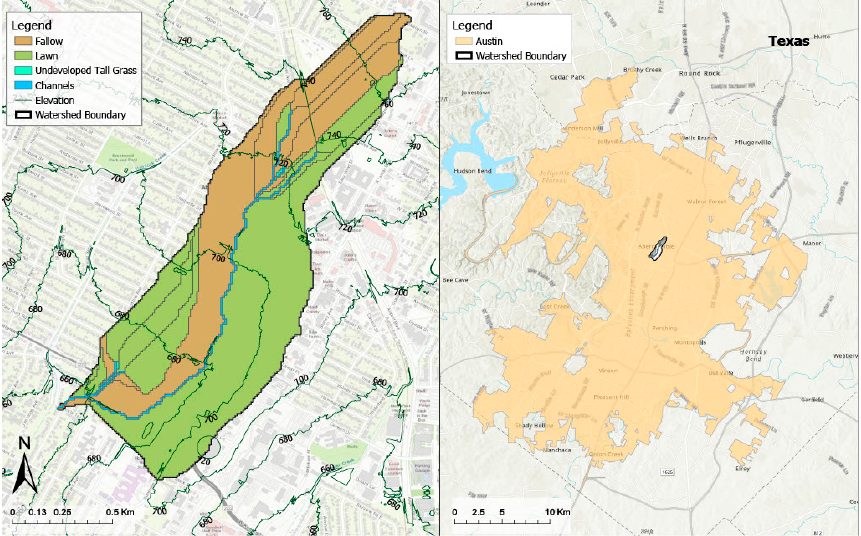
Figure 1. Land use types, elevation, and channel network of the Brentwood watershed.